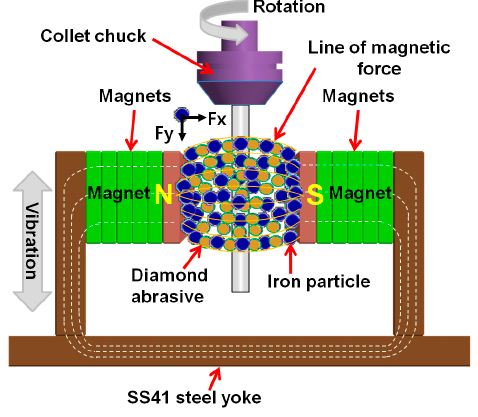
Figure 1. Schematic of ultra-high-speed micro magnetic abrasive machining principle.